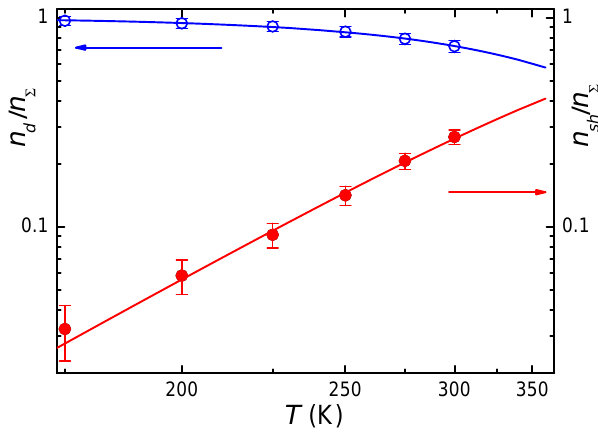
Figure 6. The same as in Figure 5, but for CdF